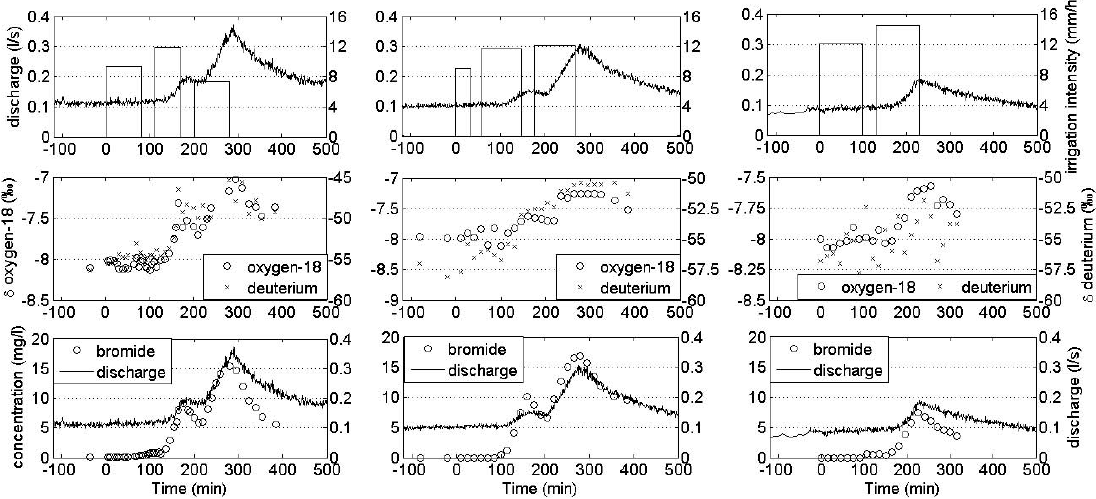
Fig. 2. Summary of the experiments, left column is experiment 1 (highest pre-experiment precipitation), center column experiment 2 (moder- ate pre-experiment precipitation), right column experiment 3 (lowest pre-experiment precipitation). Hydrographs, irrigation intensity, isotopic composition of tile-drain water, bromide and brilliant blue concentrations are